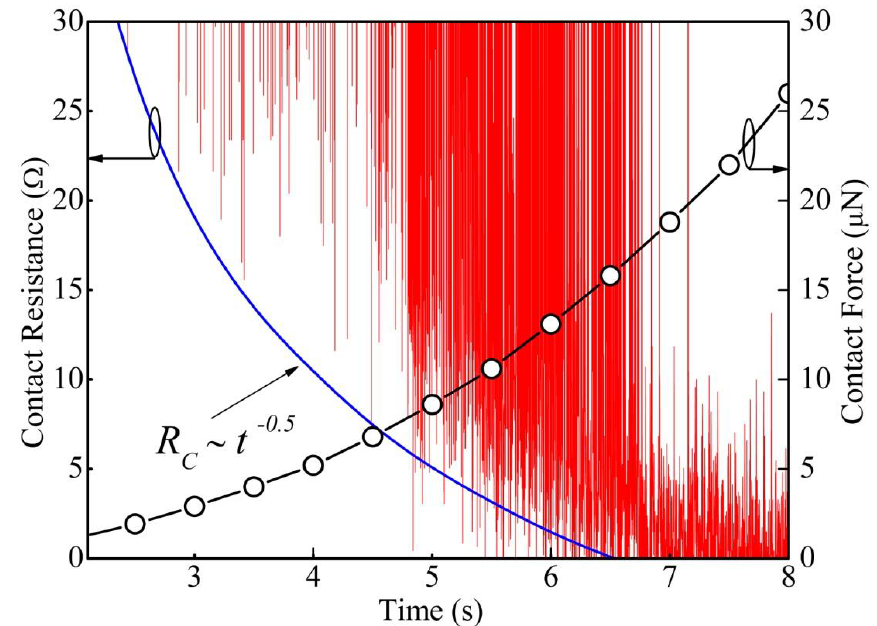
Figure 4. Contact resistance and contact force versus loading time. A relation of R is illustrated by the dashed line for